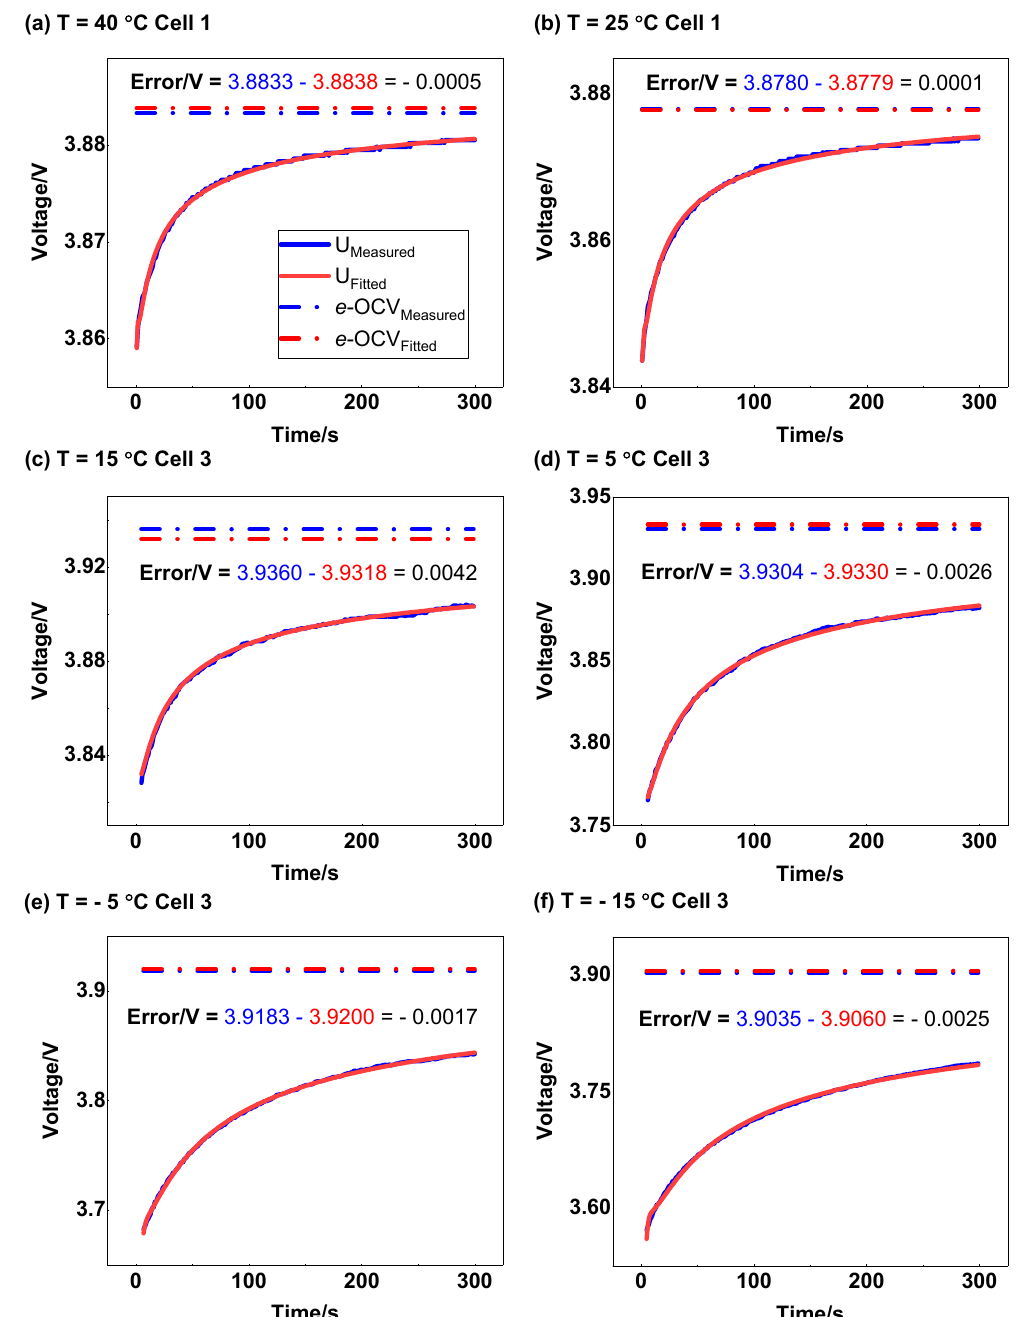
Figure 6. Results of the measured and fitted relaxation voltage of LCO/MCMB battery with 70% SOC at different temperatures: ( a ) 40 °C, ( b ) 25 °C, ( c ) 15 °C, ( d ) 5 °C, ( e ) − 5 °C, ( f ) − 15 °C. The discharge rate was 0.5 C. ( a , b ) were extracted from Cell 1 and ( c – f ) were extracted from Cell 3 as supplementary experiments.